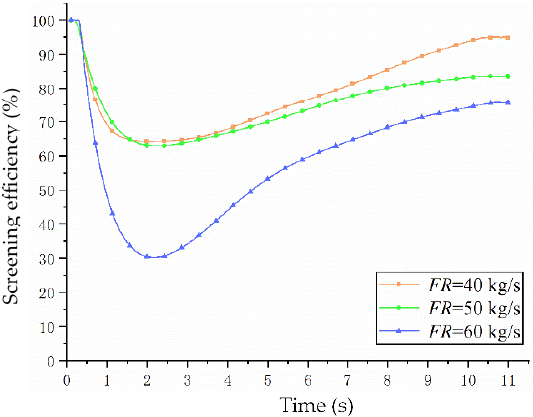
Figure 18. Changes in screening efficiency.